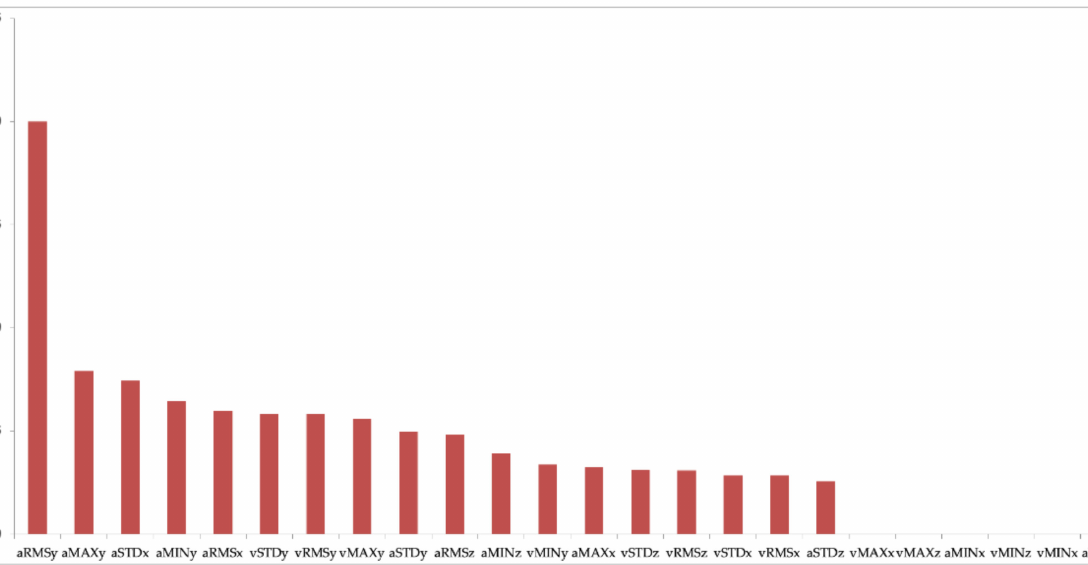
Figure 5. Feature importance based on the Information Gain value. Abbreviations. aRMSx: x -axis acceleration Root Mean Square; aRMSy: y -axis acceleration Root Mean Square; aRMSz: z -axis acceleration Root Mean Square; aSTDx: x -axis acceleration Standard Deviation; aSTDy: y -axis acceleration Standard Deviation; aSTDz: z -axis acceleration Standard Deviation; aMINx: x -axis acceleration Minimum; aMINy: y -axis acceleration Minimum; aMINz: z -axis acceleration Minimum; aMAXx: x -axis acceleration Maximum; aMAXy: y -axis acceleration Maximum; aMAXz: z -axis acceleration Maximum; vRMSx: x -axis angular velocity Root Mean Square; vRMSy: y -axis angular velocity Root Mean Square; vRMSz: z -axis angular velocity Root Mean Square; vSTDx: x -axis angular velocity Standard Deviation; vSTDy: y -axis angular velocity Standard Deviation; vSTDz: z -axis angular velocity Standard Deviation; vMINx: x -axis angular velocity Minimum; vMINy: y -axis angular velocity Minimum; vMINz: z -axis angular velocity Minimum; vMAXx: x -axis angular velocity Maximum; vMAXy: y -axis angular velocity Maximum; vMAXz: z -axis angular velocity Maximum.